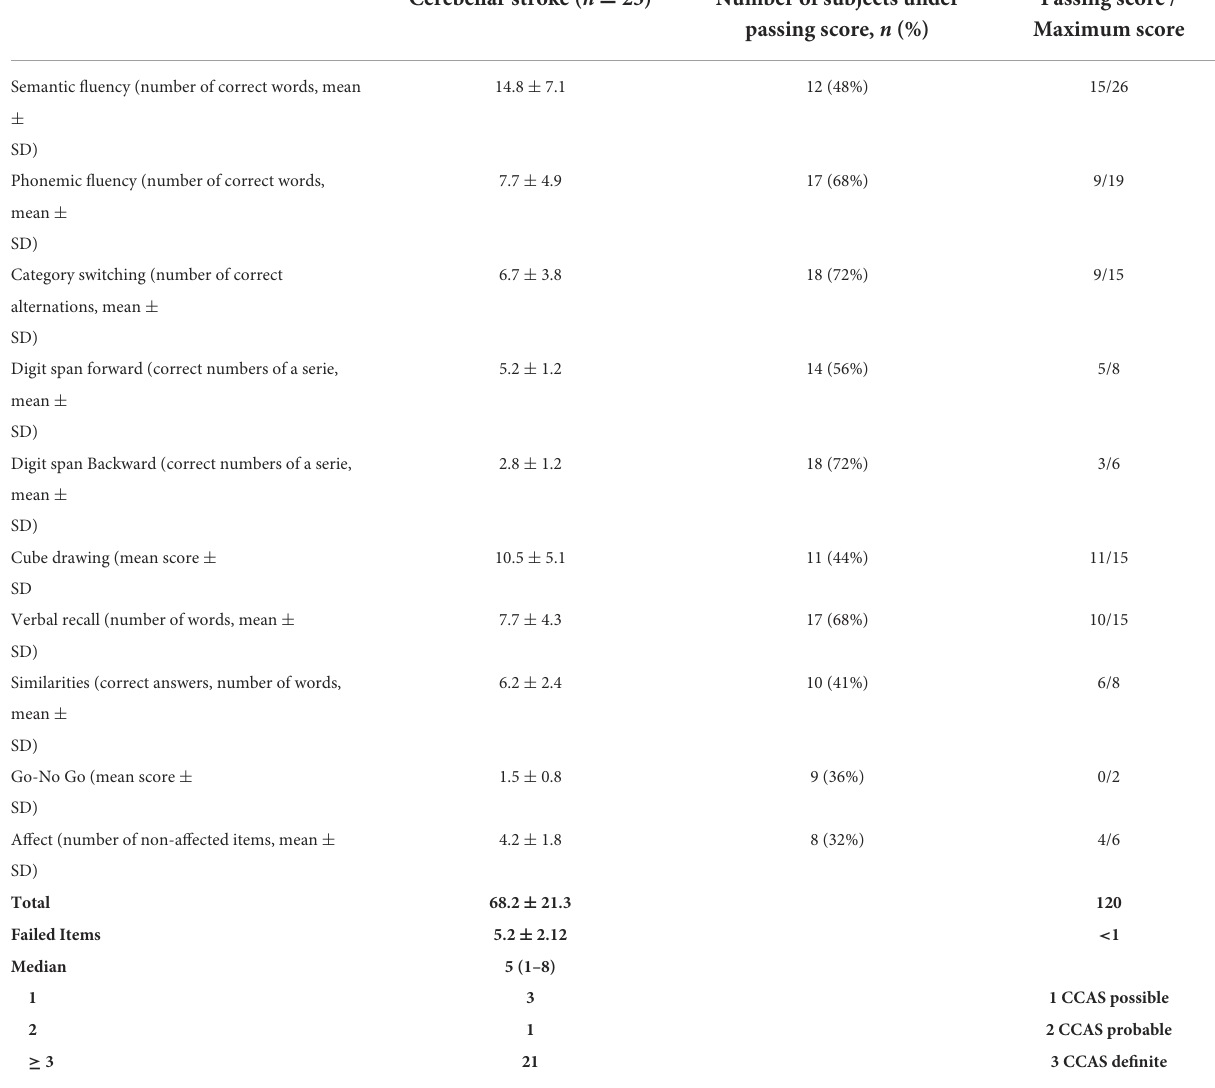
Cerebellar stroke ( n = 25) Number of subjects under